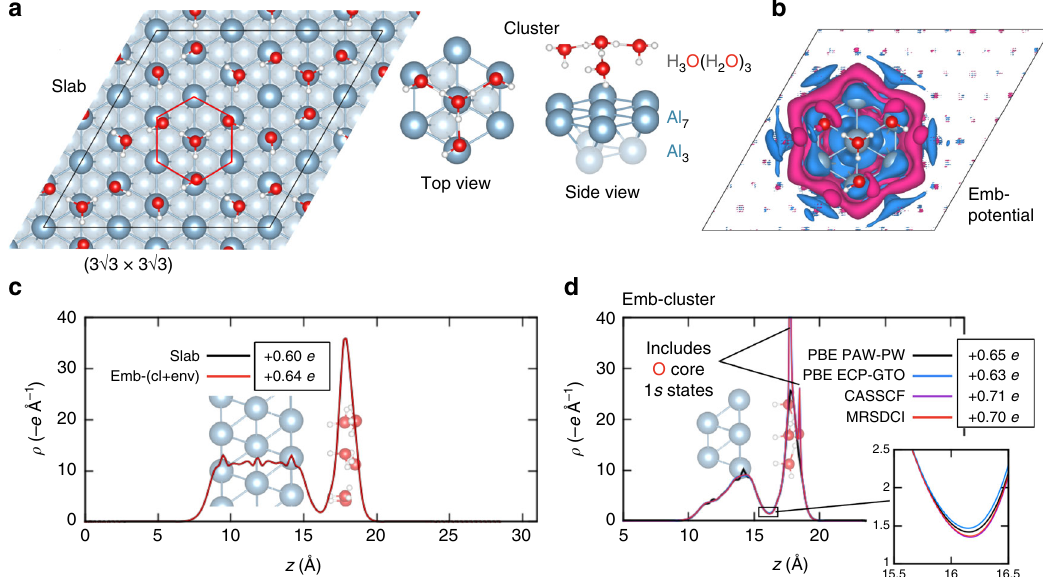
ffiffiffi p ffiffiffi p Þ ´ 3 3 3 ) R 30° three-layer Al